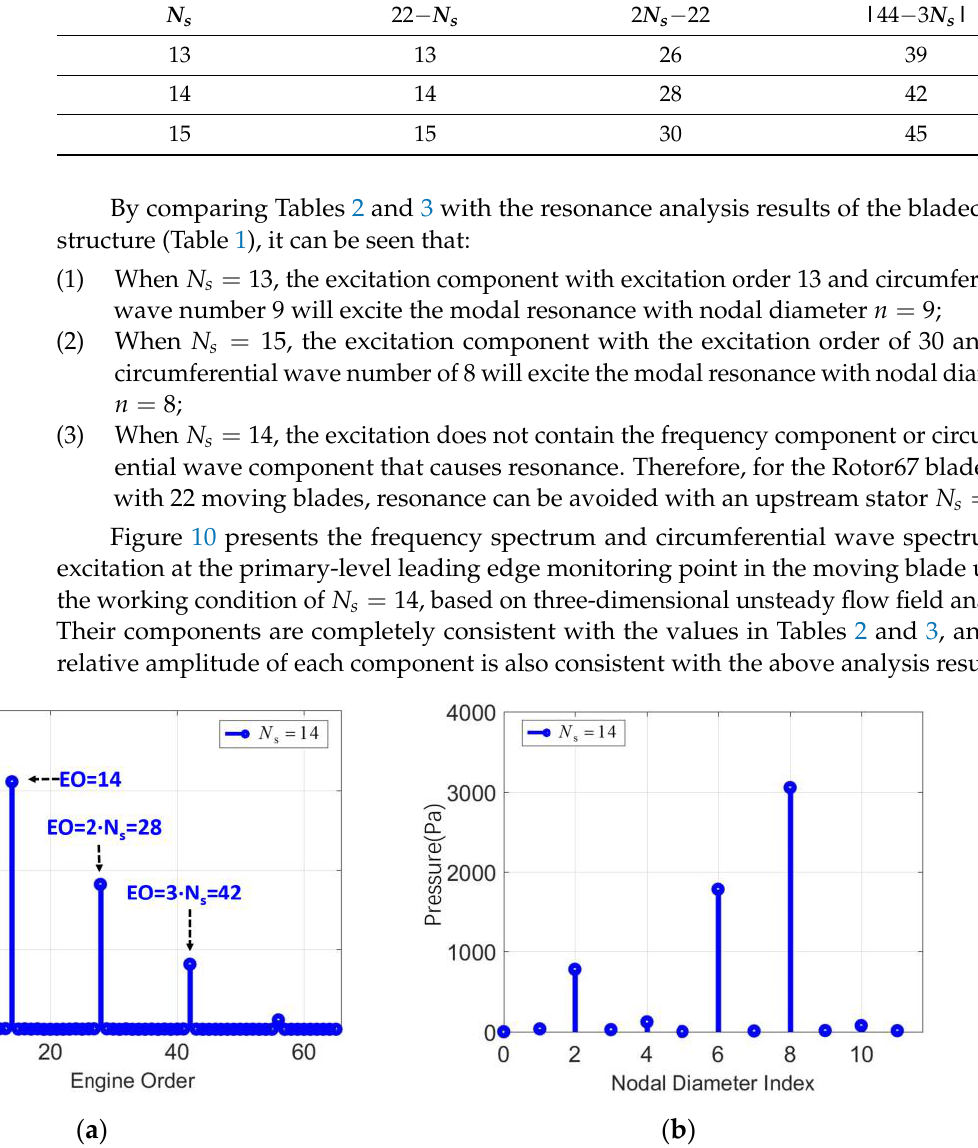
Table 4. Excitation harmonic components in the wake of the stator with respective periods. N s